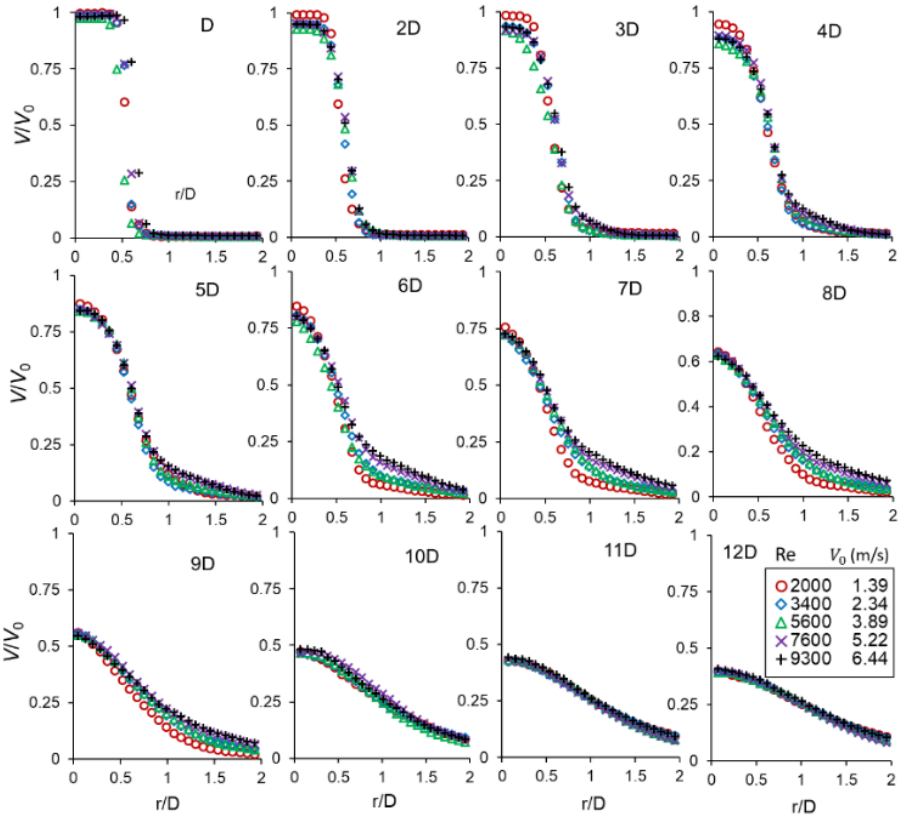
Figure 4. Normalized streamwise velocity profiles at different downstream distances (half of the profiles is shown).